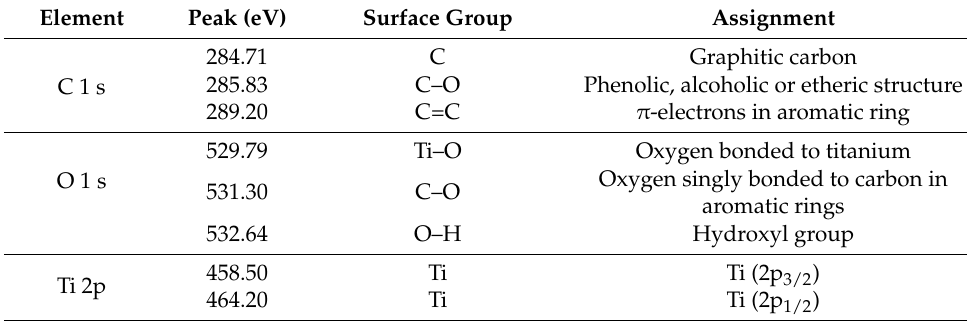
Table 6. The assignment of the XPS peaks of CQDs/TiO 2 composite based on WRN.